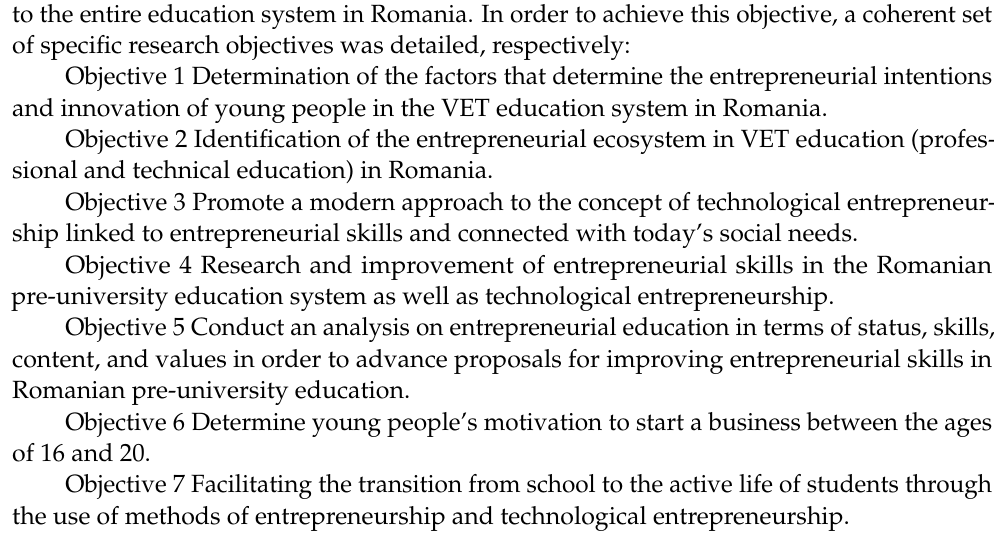
Table 4. Which aspects of behavior regarding attitudes and perceptions, do you think that can be developed in the study of entrepreneurship? (Question 1).